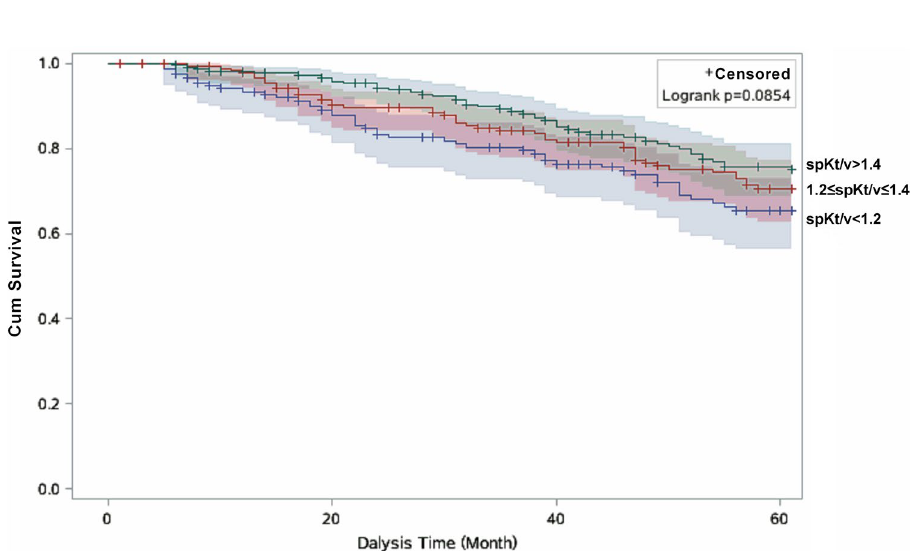
Figure 2. Kaplan–Meier survival estimates of cardiovascular disease mortality between the three the dose of hemodialysis subgroups divided by the optimal cutoff